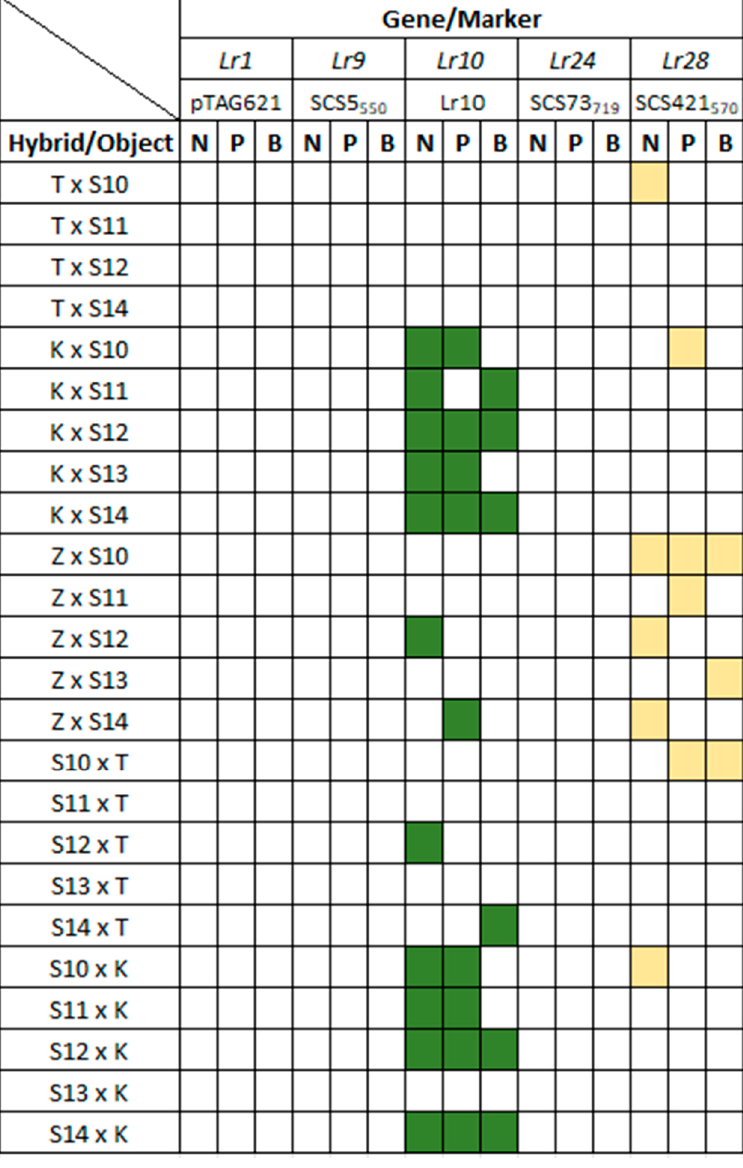
Figure 8. Identification of gene markers associated with wheat resistance to P. triticina in bread wheat and spelt lines Key: T—cv. Torka, Z—cv. Zebra, K—cv. Kontesa, N—null lines (e.g., T × S10 is abbreviated as 1), P—prim lines (e.g., T × S10 ′ is abbreviated as 1 ′ ), B—bis lines (e.g., T × S10 ″ is abbreviated as 1 ″ ).